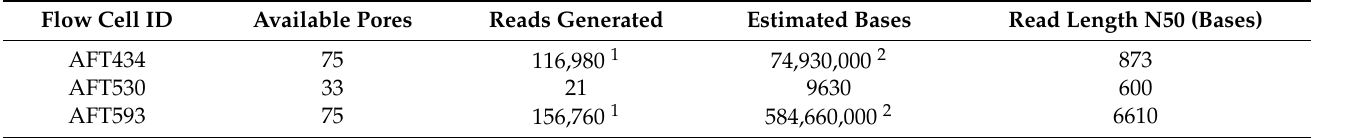
Table 2. Overview of sequencing.